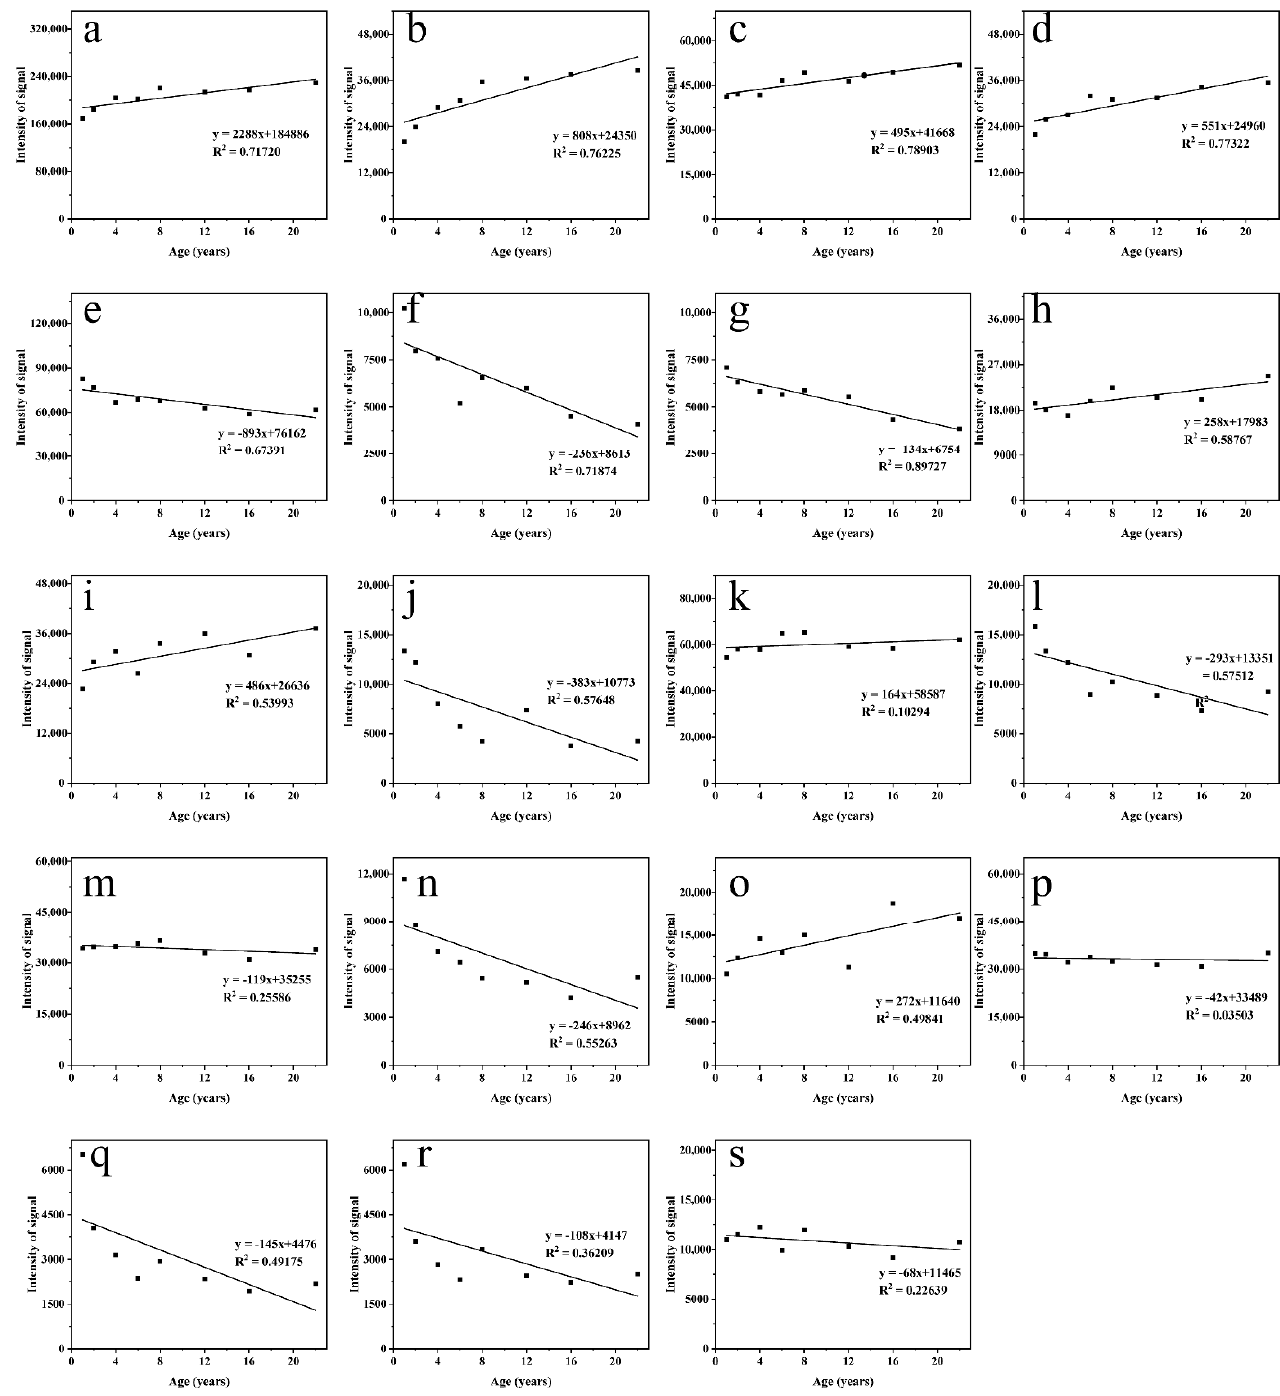
Figure 5. Scatter plots of the changes in voltage intensity of ethyl hexanoate A ( a ), propyl hexanoate A ( b ), ethyl pentanoate A ( c ), ethyl heptanoate A ( d ), ethyl acetate A ( e ), 2-methyl-1-propanol ( f ), methylpropanal B ( g ), butan-2-ol A ( h ), octanoic acid ethyl ester B ( i ), isoamyl acetate A ( j ), ethyl butyrate A ( k ), nonanal ( l ), ethyl hexanoate ( m ), ethyl lactate ( n ), 2-methyl butanoic acid ethyl ester A ( o ), 3-methyl-1-butanol ( p ), octanal ( q ), furfural A ( r ), and 1-hexanol A (s).